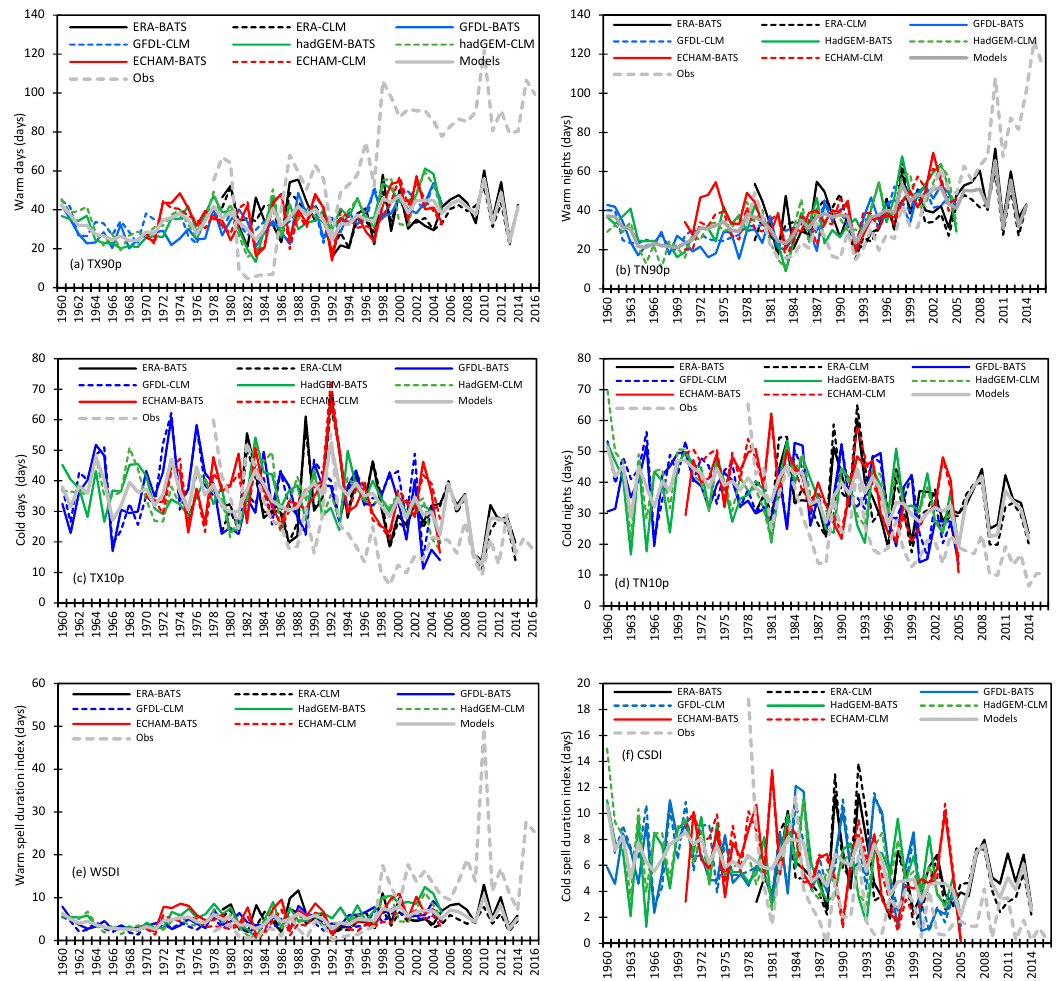
Figure 10. Comparison of simulation based temperature indices ( a ) warm days, ( b ) warm nights, ( c ) cold days, ( d ) cold nights, ( e ) warm spell duration index, and ( f ) cold spell duration index, with the same obtained from observations for entire period of data available corresponding to each dataset.